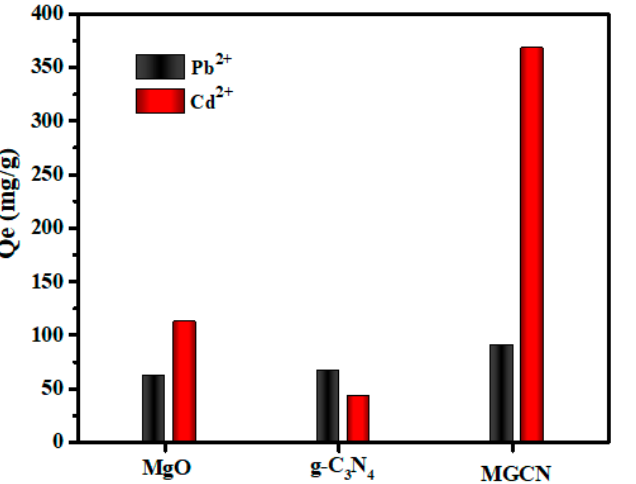
Figure 5. Pb ++ and Cd ++ adsorption capacities of MGCN, g-C 3 N 4 , and MgO with an initial Pb ++ and Cd ++ concentration of 45 ppm and initial pH = 5.